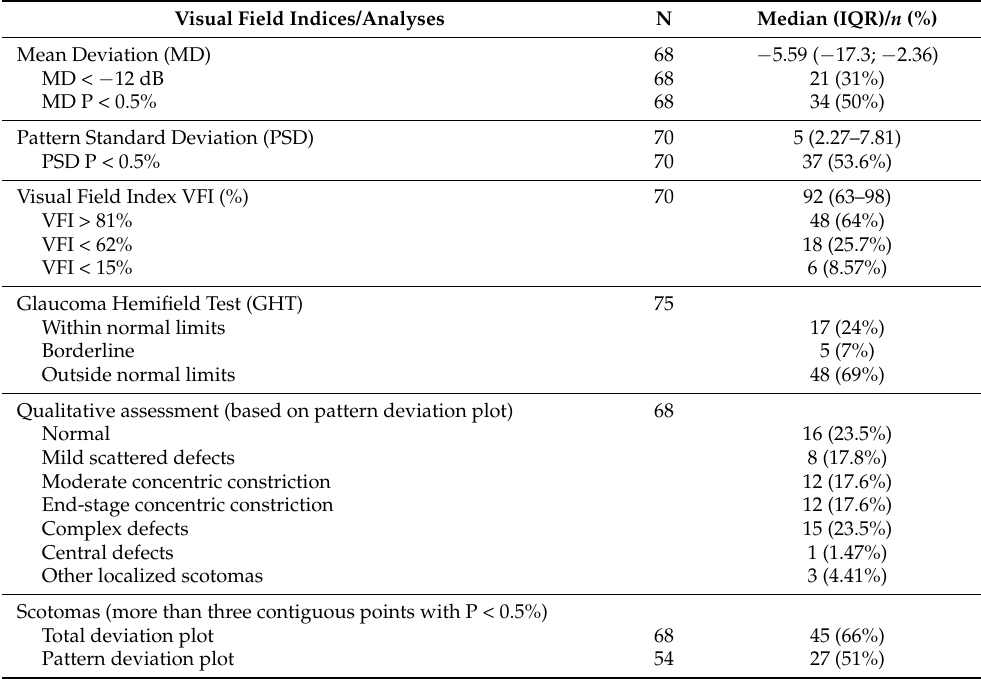
Table 2. Distribution of automated visual field indices and qualitative analyses of